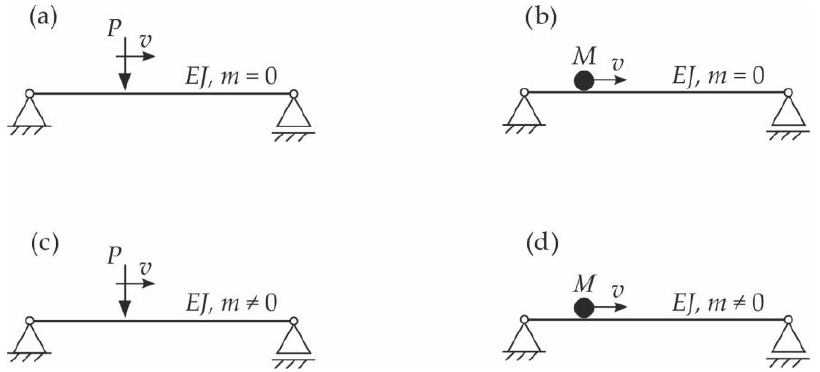
Figure 1. Dynamic diagrams of a simply supported beam under non-inertial and inertial moving loads: ( a ) the problem of structural mechanics (influence line), ( b ) the problem of Willis–Stokes (1849), ( c ) the problem of Kriloff (1905), and ( d ) the problem of Inglis (1934) and Renaudot (1861) [3].